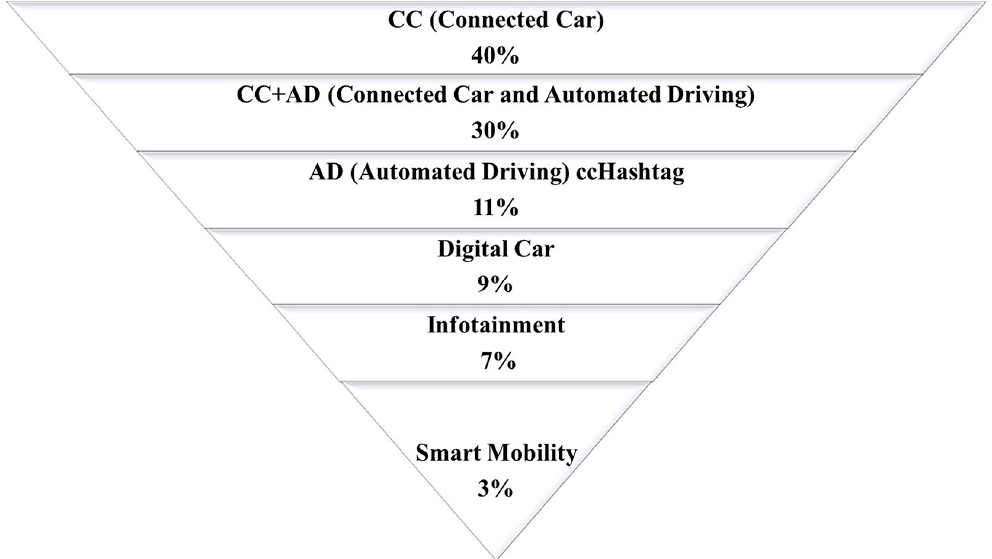
Figure 5. Topic distribution in the “News/Information” subcategory (n = 618 (100%)) .